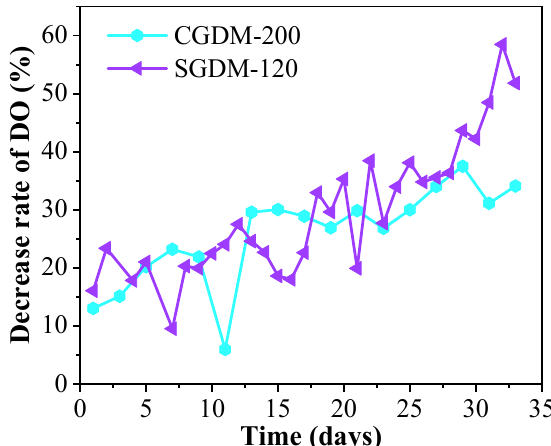
Figure 5. Trend of DO